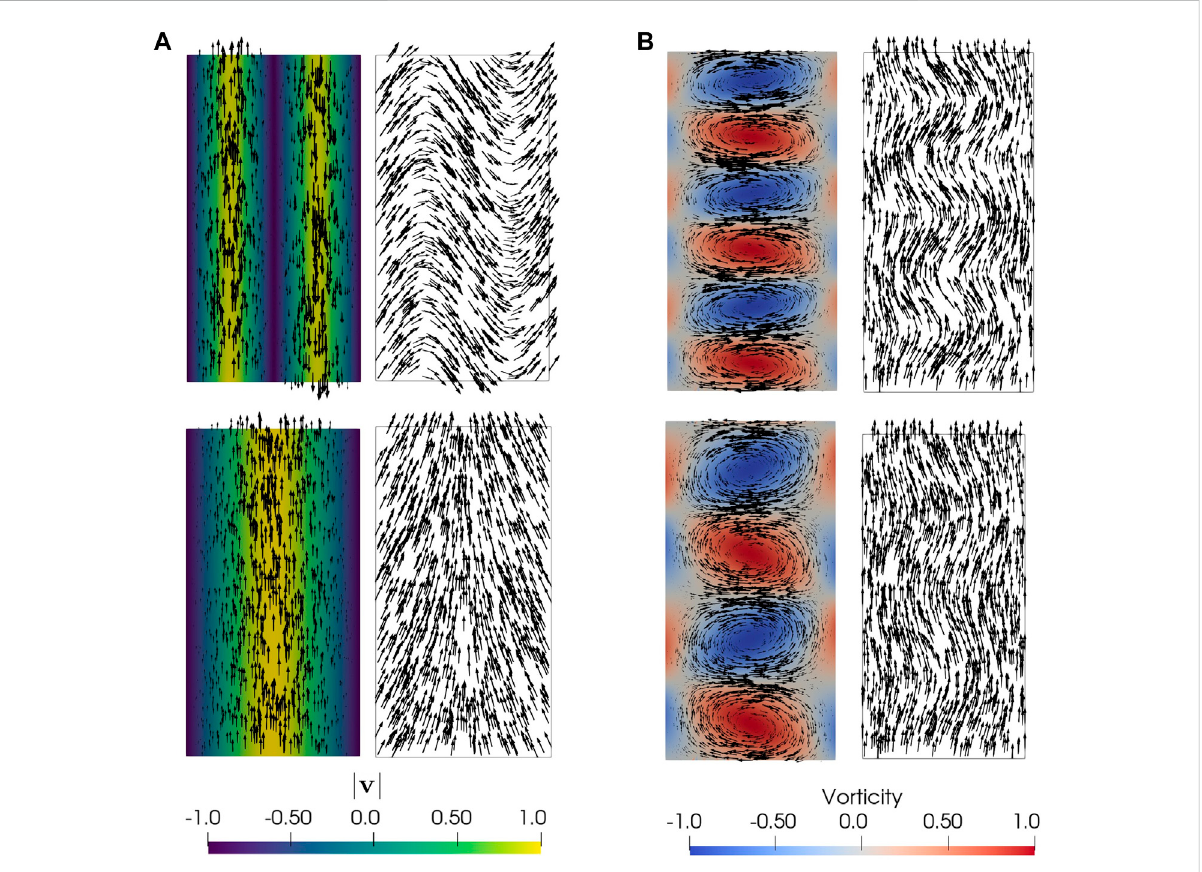
FIGURE 4 Some of the steady states observed in the phase diagrams ( ℓ η = 0.35) are shown in terms of the fl ow v (left in each frame) and the polarization p (right). The vorticity and the fl ow magnitude are colorized to show relative magnitudes and have been scaled by the corresponding maximum/ minimum. The arrows represent the vectors for v and p scaled by their magnitudes. ℓ κ . (A) Steady States with weak anchoring, ℓ κ W =100, and low activity (bottom, α -1.75) and high activity (top, α =-4.00). (B) Steady States with strong anchoring, ℓ κ W =0.01, and low activity (bottom, α -2.00) and high activity (top, α